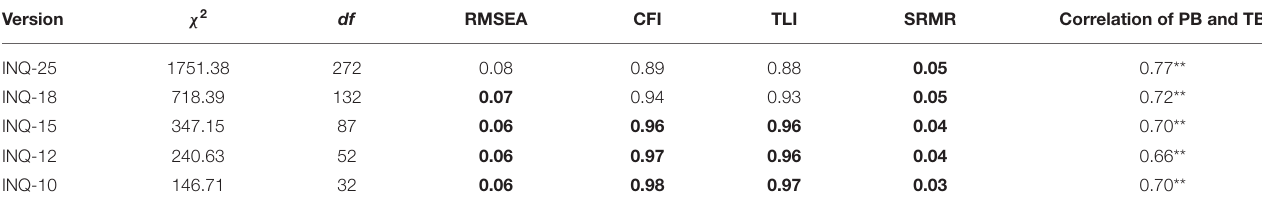
TABLE 2 | Global fit indices and correlations between subscales.